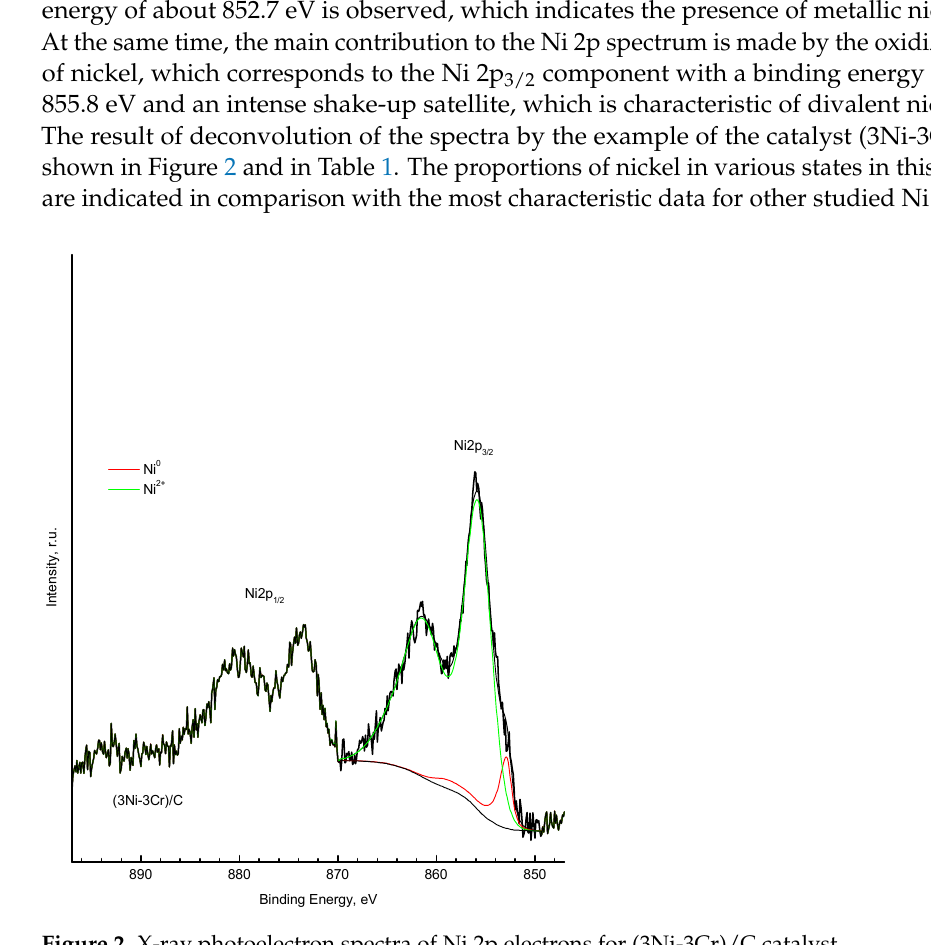
Figure 2. X-ray photoelectron spectra of Ni 2p electrons for (3Ni-3Cr)/C catalyst. A comparison of the data in Table 1 shows that, regardless of the order of application of metals in the presence of chromium, the content of non-oxidized nickel (Ni(0)) in the creases and the more strongly, the higher the Cr content. At the same time, it can be seen that there is a peak of Ni 2p 3/2 electrons with binding energies E b = 852.7 eV in the spectra (852.5 eV) This may indicate that metallic nickel acquires some positive charge in these samples. This is also evidenced by the binding energy characterizing the second state of nickel in NiCr/C systems (Ni 2+ ). The value of the E b for this peak in the spectrum of the sample of 3Ni/C is equal to 855.8 eV, which is higher than that for the samples containing chromium. The difference in the electronic state of the components seems to indicate the presence of an interaction between these two metals. The effect is most pronounced for the 1.5Cr/3Ni/C catalyst, in which chromium is deposited on top of nickel. Table 1. The content of nickel in various degrees of oxidation on the surface of the studied samples according to the XPS data. Catalyst